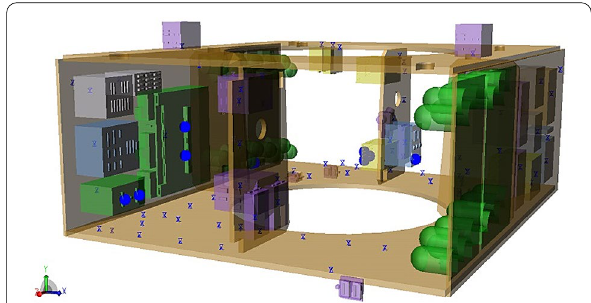
Figure 13 Endpoints in the second scenario